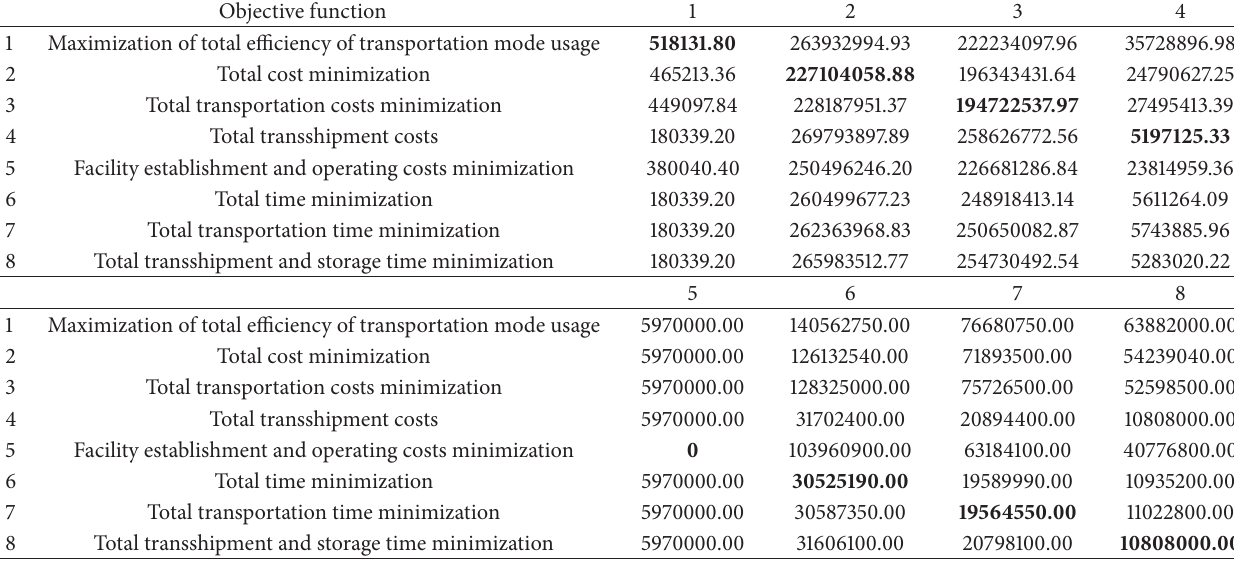
Table 19: The obtained objective function values for different decision variable